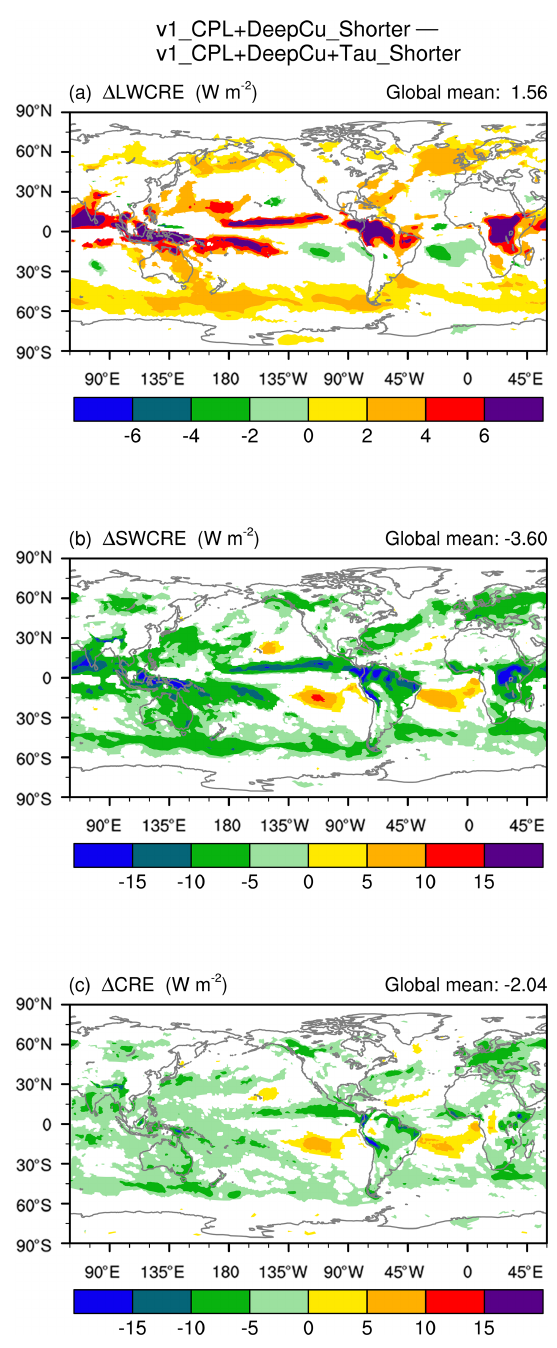
Figure B1. The 10-year annual mean CRE differences between v1_CPL + DeepCu_Shorter and v1_CPL + DeepCu + Tau_Shorter, revealing the impact of a reduced ratio of (cid:49)t/τ without model step size changes. White indicates statistically insignificant